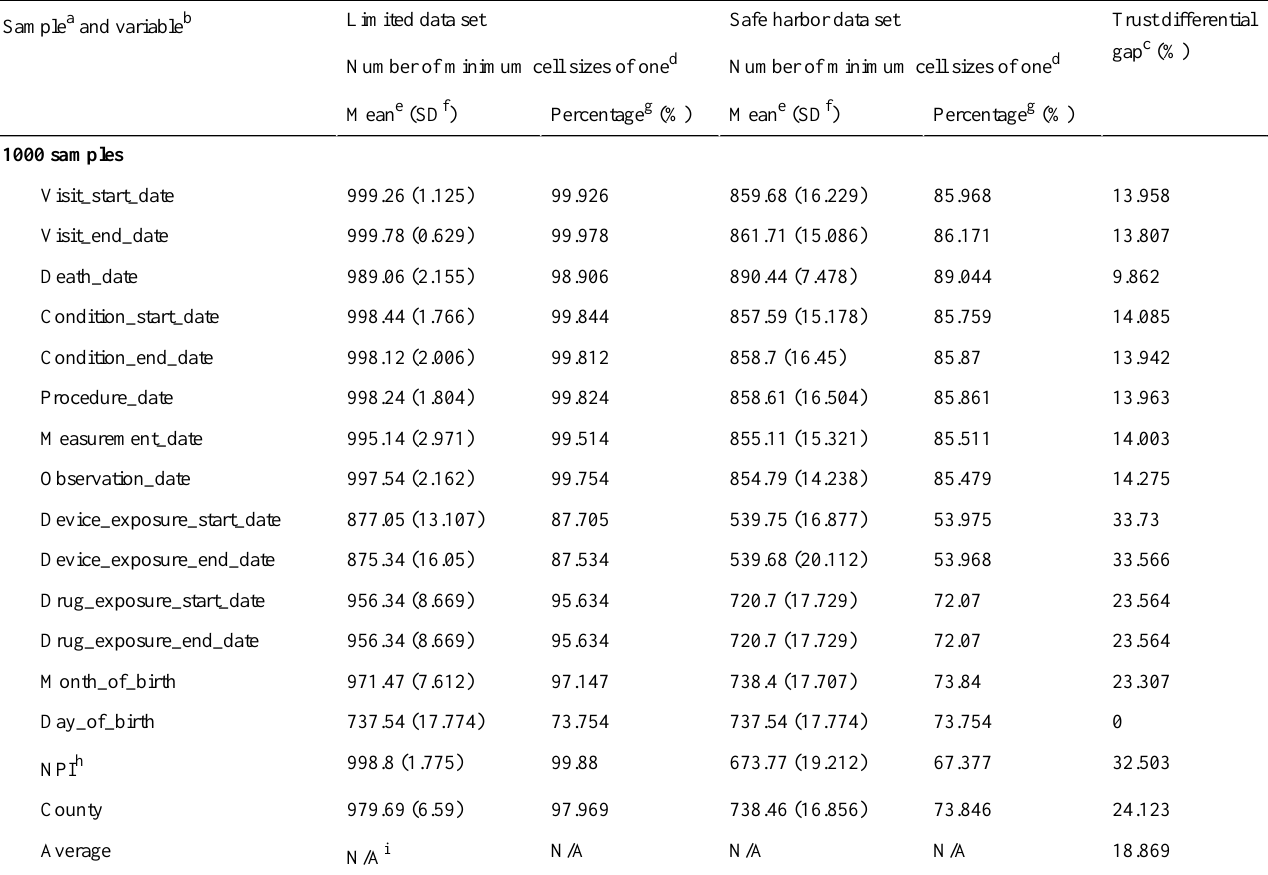
Table 4. Comparison of records with a minimum cell size of one between the limited and safe harbor data sets from 16 personal health identifier data sets.